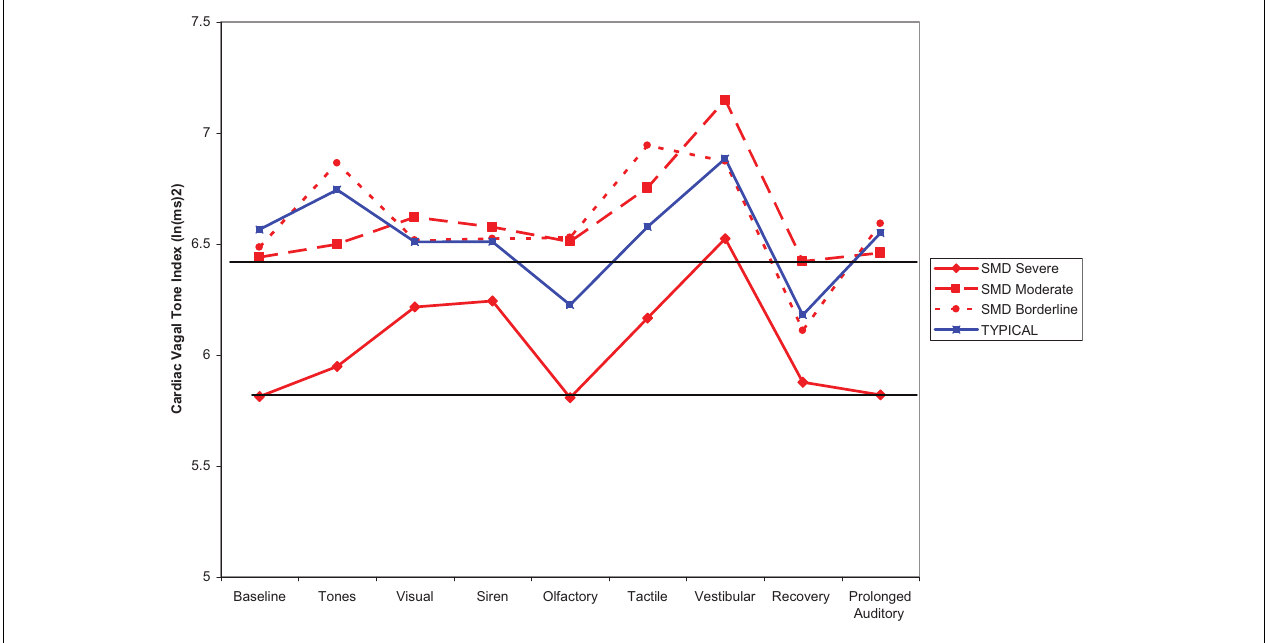
FIGURE 2 | Vagal tone for TYP in comparison to three classes of SMD.